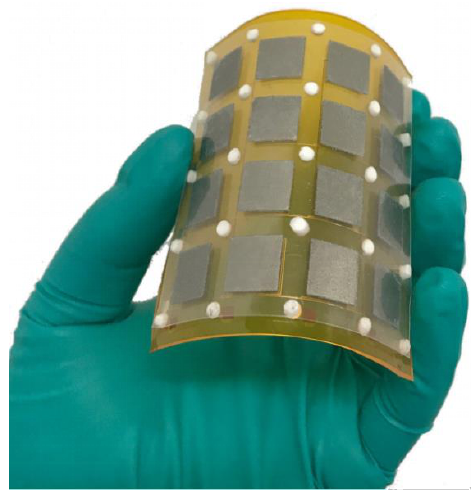
Figure 1. A photograph of a 4 × 4 inductive pressure sensor array.